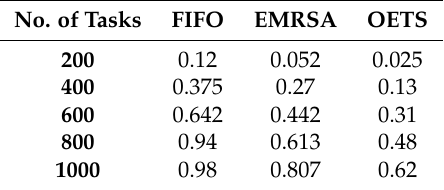
Figure 3. Energy consumption test; ( a ) multi-radio node; ( b ) current consumption recorder. Table 3. Results of energy